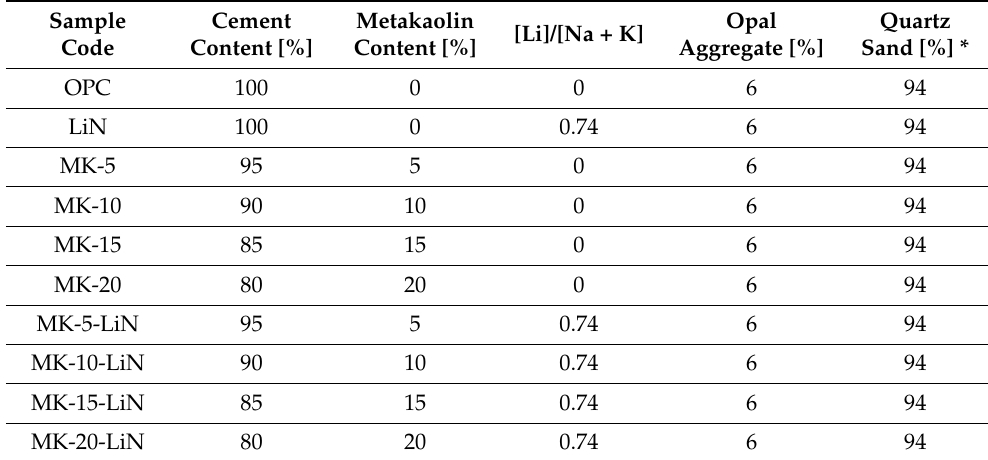
Table 2. Relative proportions of material used in preparation of mortar